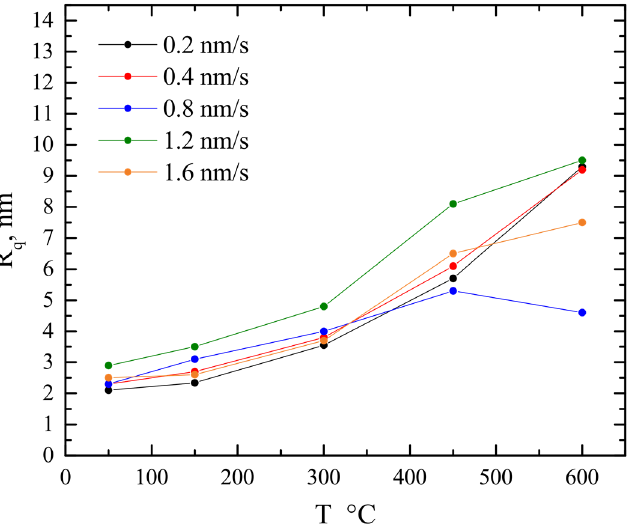
Figure 2. Roughness dependence of ScAlSZ thin films on deposition temperature.